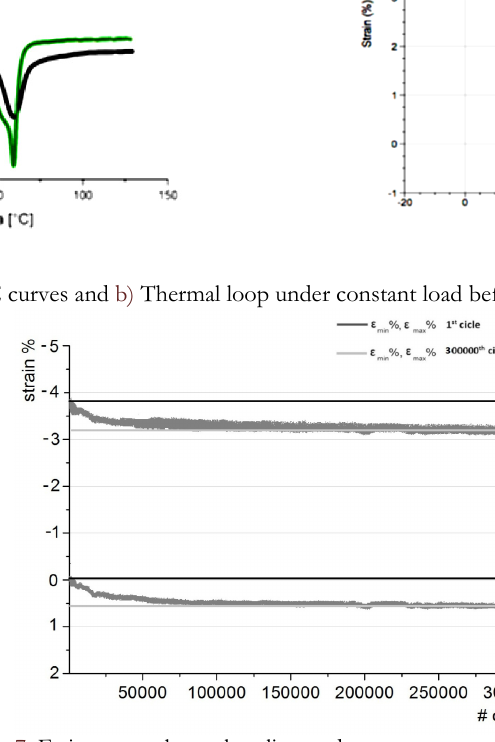
Figure 7: Fatigue test: thermal cycling under constant stress (200